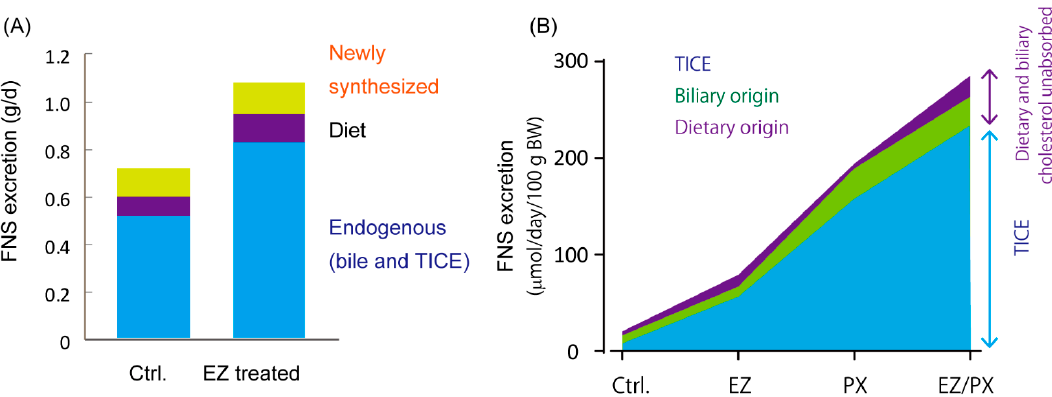
Figure 2. Stimulation of fecal neutral sterol (FNS) excretion represents an increase in trans-intestinal cholesterol efflux (TICE). ( A ) Ezetimibe (EZ)-stimulated FNS excretion results from an increase in endogenous cholesterol secretion into the gut lumen in humans, as determined by quantitative analysis with stable cholesterol isotopes (Data are obtained from Reference [56]). These findings indicate that increased FNS excretion is not attributable to the fraction of cholesterol left unabsorbed. ( B ) TICE dominates in the increase of FNS excretion in mice. Calculation of TICE in mice treated with EZ, PX20626 (PX), or both shows that the increase in FNS excretion originates from stimulated TICE (Data are obtained from Reference [11]). PX20606, a farnesoid X receptor agonist.